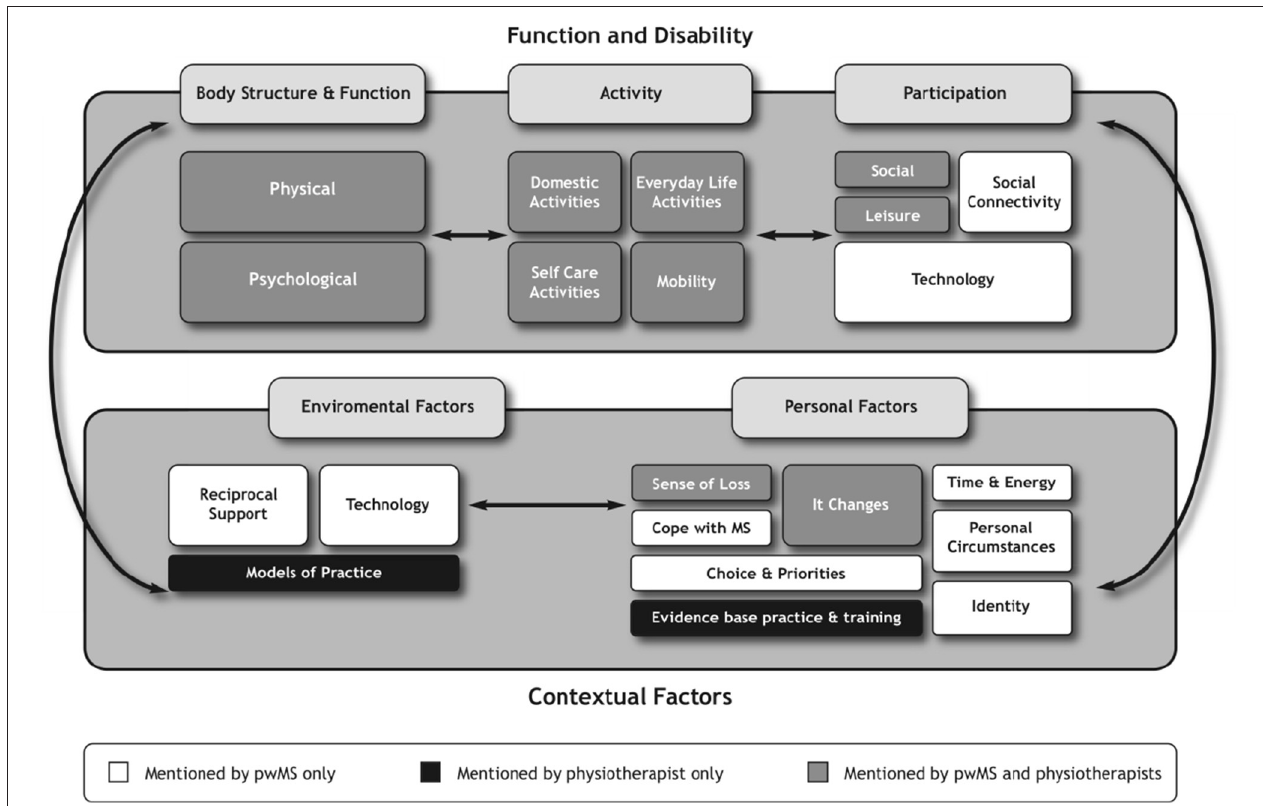
FIGURE 4 | Representation of the experiential and professional perspective in relation to the